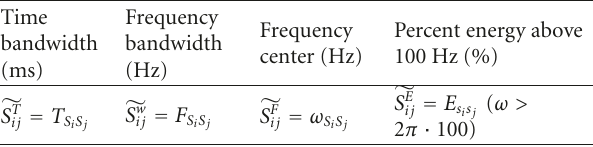
Table 1: Example of matrices created due to single walk file assuming three footfalls in